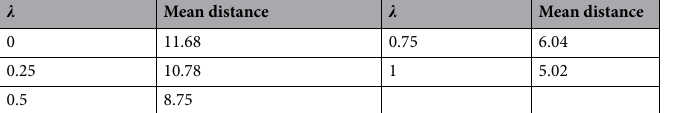
Table 3. Mean distance between the theoretical prediction in (4) and the mean curve we obtain from bootstrapping the observed angles (see Sect. A.3.3) for several sensorimotor errors that are obtained as convex combinations of the exponential quadratic error (1) and the Mexican hat (10). In particular, we consider sensorimotor errors of the form (cid:31) f + ( 1 − (cid:31) ) g , where (cid:31) = 0, 0.25, 0.5, 0.75, 1 , f is the exponential quadratic error with b = 0 and β = 4 (which are close to the values fitted for the participants) and g is the Mexican hat with σ = 4 . As expected, the mean distance diminishes as the weight of the exponential quadratic error